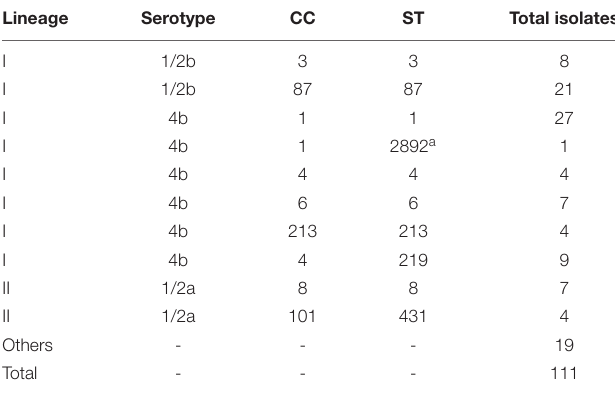
TABLE 2 | Distribution of lineages, serotypes, clonal complexes (CCs), and sequence types (STs) of L. monocytogenes isolates in Gipuzkoa,